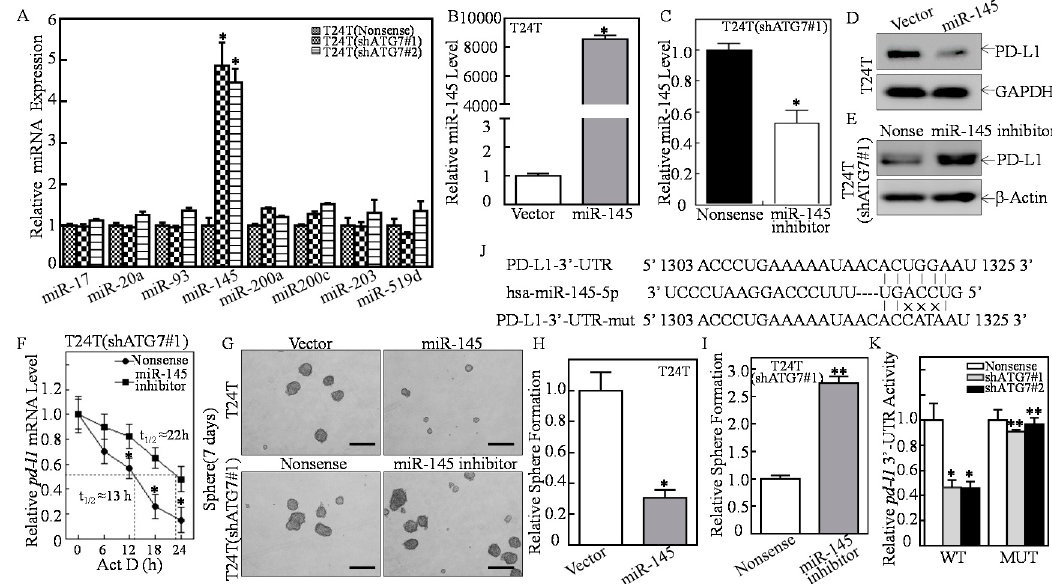
Figure 3. miR-145 was an ATG7 downstream regulator being responsible for stabilization of pd-l1 mRNA via direct binding to its 3 ′ -UTR. ( A ) Quantitative Real-time PCR was carried out to determine the expression of miRNAs in the indicated cells. The bars show mean ± SD from three independent experiments. The double asterisk (*) indicates a significant increase in comparison to T24T(Nonsense) cells (* p < 0.05). ( B ) miR-145 overexpression plasmids were stably transfected into T24T cells. The stable transfectants were identified by Real-time PCR. Bars represent mean ± SD from three independent experiments. Student’s t -test was utilized to determine the p -value and the asterisk (*) indicates a significant increase in comparison to scramble vector transfectant (* p < 0.05). ( C ) miR-145 inhibitor plasmids were stably transfected into T24T(shATG7#1) cells. The stable transfectants were identified by Real-time PCR. Bars represent mean ± SD from three independent experiments. Student’s t -test was utilized to determine the p -value and the asterisk (*) indicates a significant decrease in comparison to scramble vector transfectant (* p < 0.05). ( D , E ) Cell lysates extracted from the indicated cells were subjected to Western Blot for determining the protein expression of PD-L1. GAPDH was used as a loading control. ( F ) T24T(shATG7#1/miR-145) cells and T24T(shATG7#1/Nonsense) cells were seeded into 6-well plates. After synchronization, the cells were treated with Actinomycin D (Act D) for the indicated time points, then total RNA was isolated and subjected to Real-time PCR analysis for mRNA levels of pd-l1 , and gapdh was used as an internal control. ( G – I ) The indicated cells were subjected to determination of sphere formation abilities according to the manufacturer’s instruction, the number of spheroid formed cells were counted as described in the section of “Materials and Methods”. The asterisk (*) indicates a significant decrease in comparison to Vector control transfectant (* p < 0.05), while the symbol (**) indicates a significant increase in comparison to T24T(shATG7#1/Nonsense) cells (** p < 0.05). ( J ) Schematic of the construction of the pd-l1 mRNA 3 ′ -UTR luciferase reporter and its mutants were aligned with miR- 145. ( K ) Wild-type and mutant of pd-l1 3 ′ -UTR luciferase reporters were transiently co-transfected with pRL-TK into the indicated cells, respectively. Luciferase activity of each transfectant was evaluated and the results were presented as relative pd-l1 3 ′ -UTR activity. The bars show mean ± SD from three independent experiments. The double asterisk (**) indicates a significant restoration of 3 ′ - UTR activity in mutant transfectant in comparison to mutant of WT pd-l1 3 ′ -UTR luciferase reporter transfectant (** p < 0.05) of T24T(shATG7) cells in comparison to that of T24T(Nonsense) cells (* p < 0.05). Scale bars in ( G ) = 200 μ m.